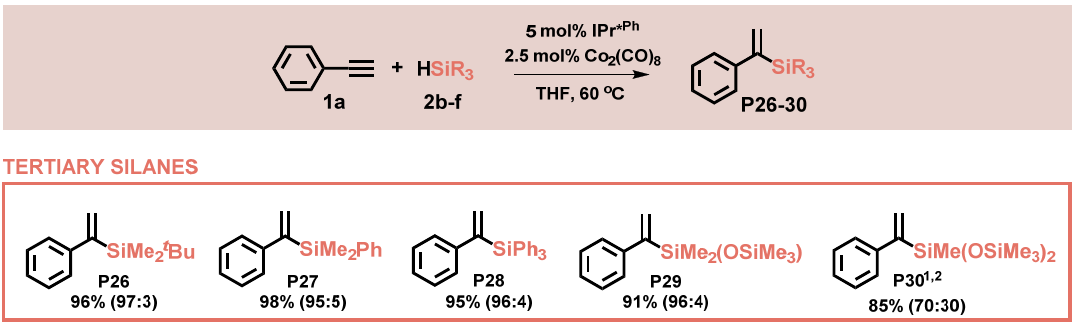
Figure 4. Substrate scope—tertiary silanes. Reaction conditions: argon, THF, 60 ◦ C, 5 h, [ 1a ]:[ 2b-f